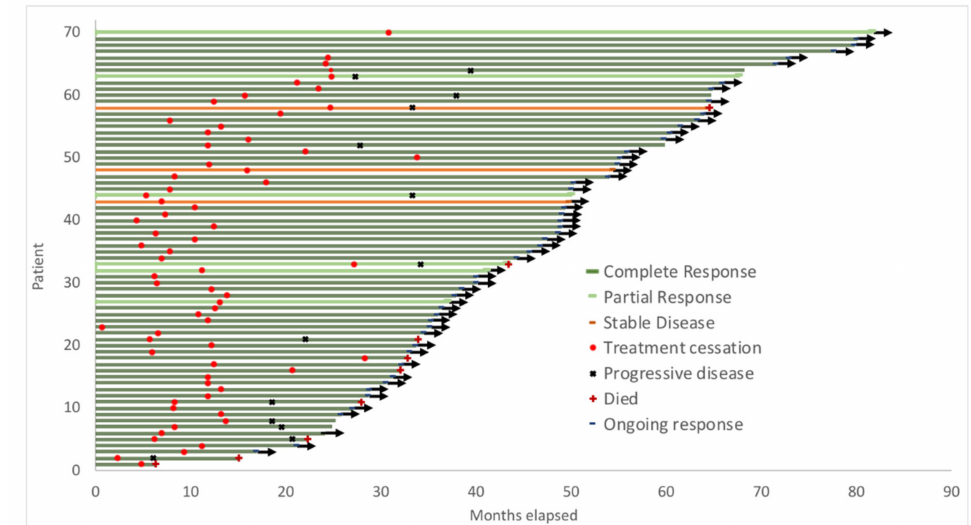
Figure 2. Swimmer plot indicating time on anti-PD1 therapy, progression-free survival and overall survival following disease